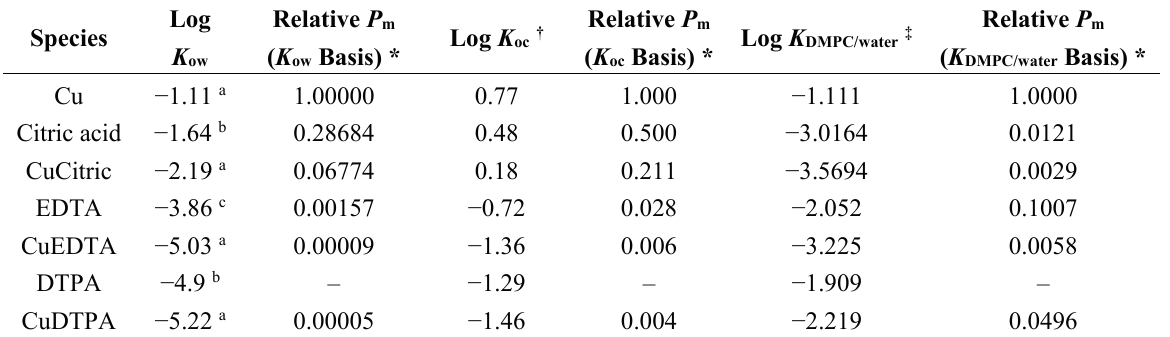
Table A3. Membrane permeability of Cu, amendment ligands and complex species estimated using K ow and K DMPC/water